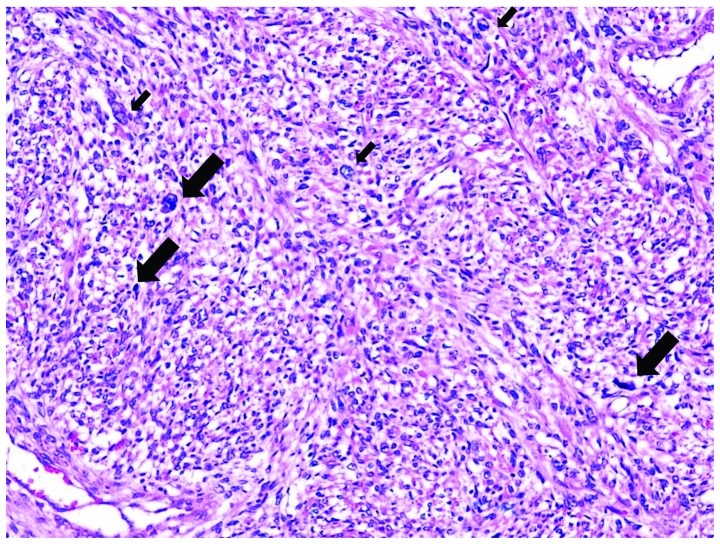
Surgical specimen showing smooth muscle cells with nuclear atypia (small arrows) and a high mitotic index, with >10 mitotic figures per high power field (large arrows). Hematoxylin and eosin staining; magnification, ×20.